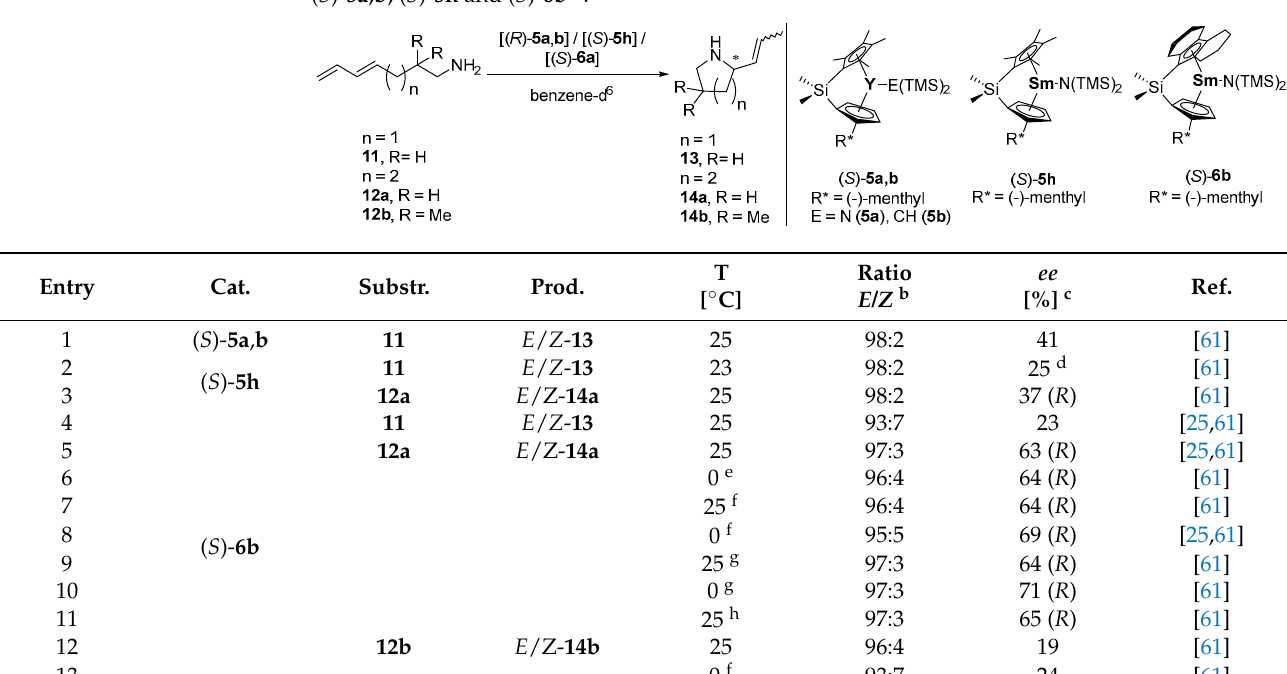
Table 3. Catalytic asymmetric hydroamination of 11 and 12a , b using chiral rare earth metal complexes